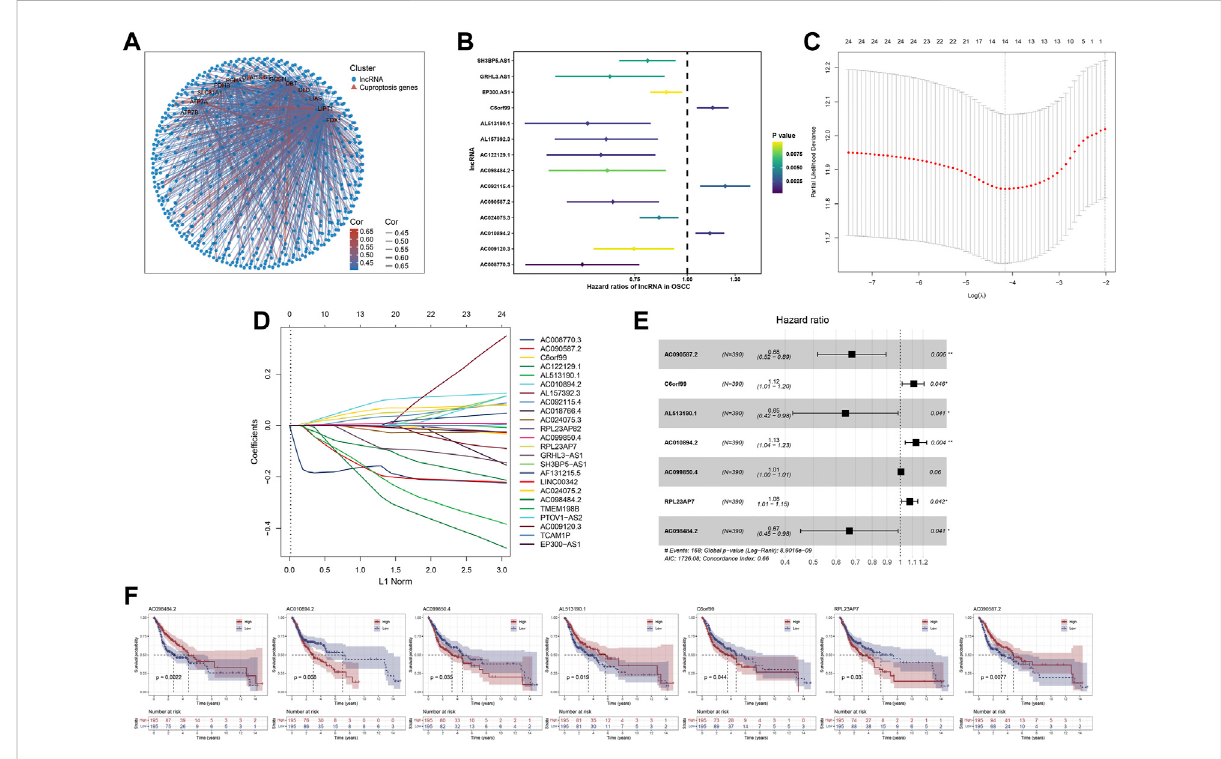
FIGURE 2 Identi fi cation of cuproptosis-related lncRNA based prognostic signature. Notes: (A) Correlation analysis between the expression of cuproptosis-related genes and the lncRNAs. (B) Univariate cox regression analysis of cuproptosis-related lncRNAs. (C , D) Lasso regression analysis screened 24 cuproptosis-related lncRNAs (E) Forest plot of 7 prognostic lncRNAs identi fi ed by multivariate cox regression analysis (F) Kaplan-Meier survival curves of signature lncRNAs in